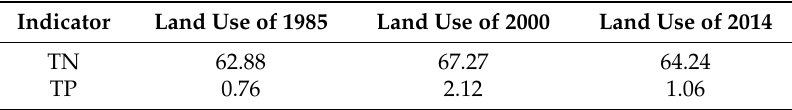
Table 11. The incidence of water pollution (%) under the LUCC